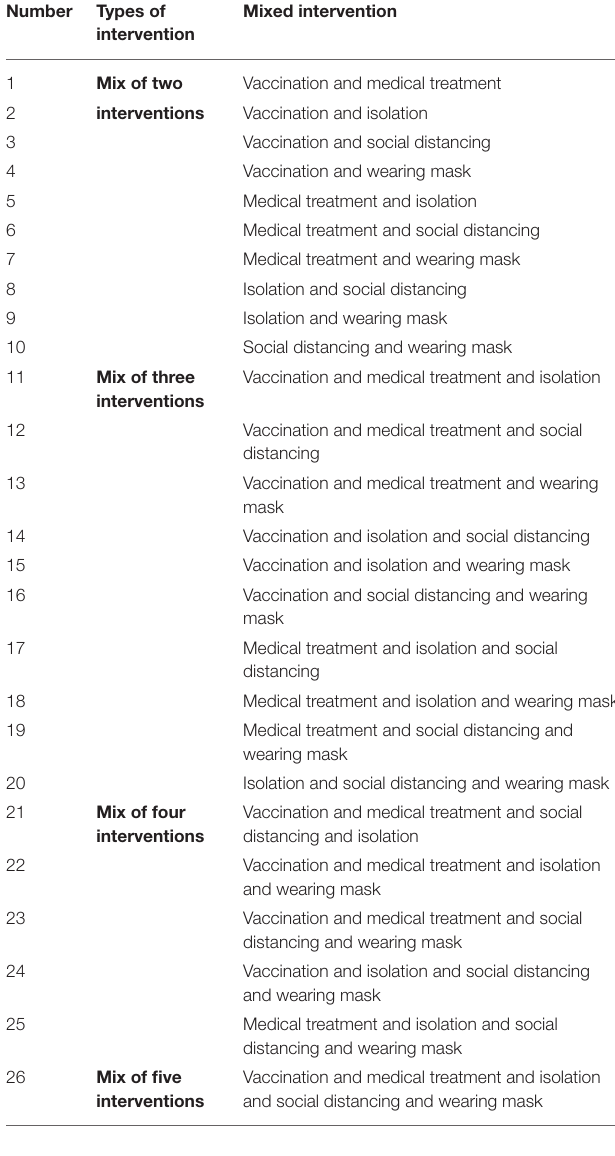
TABLE 2 | Combination of different